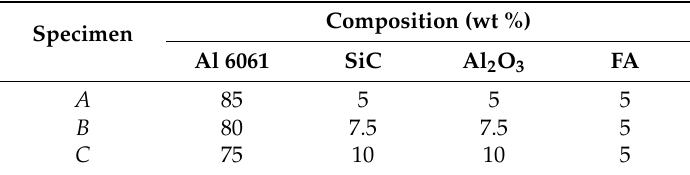
Table 1. Composition of proposed hybrid metal matrix composite (MMC) for different specimens.